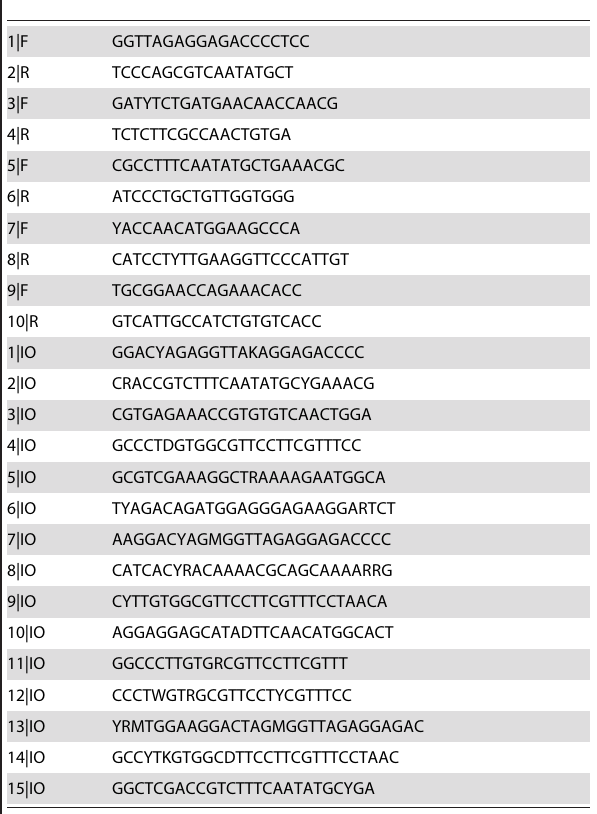
Table 5. Multiplex set of primers and probes to detect all 2863 Dengue virus